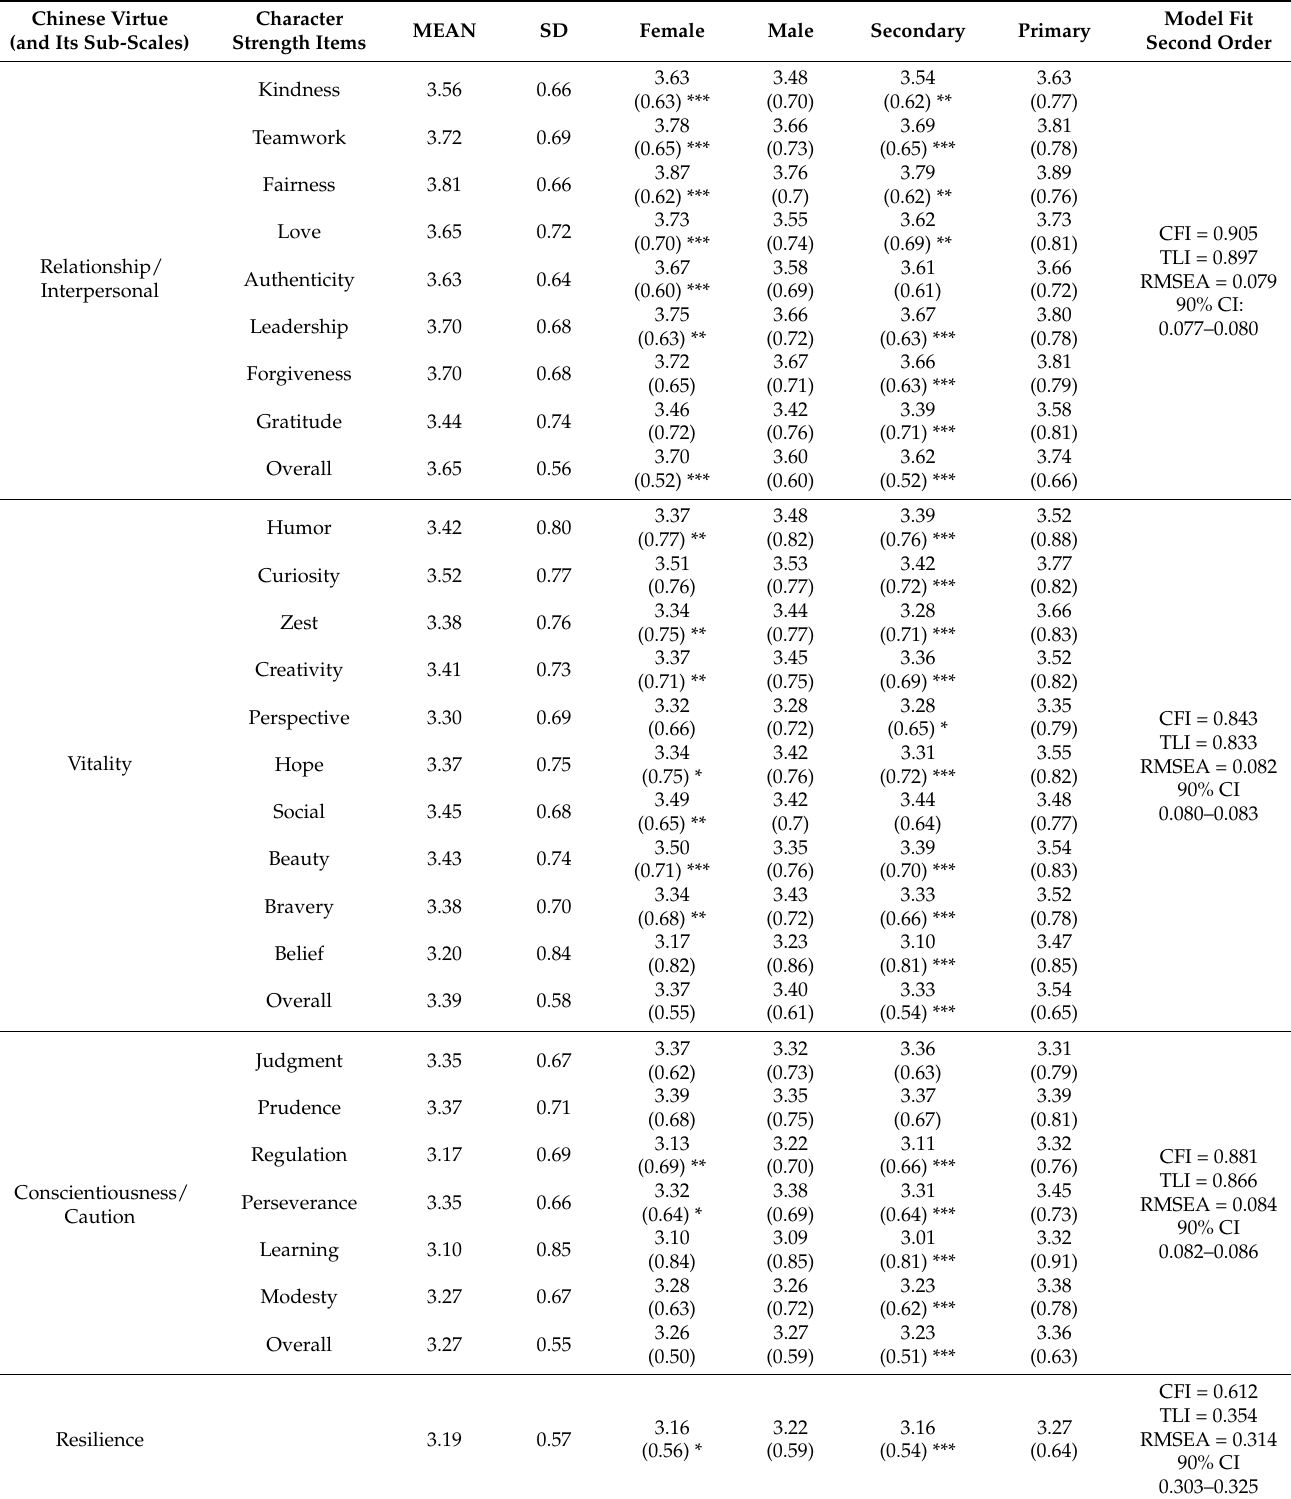
Table 1. Descriptive Statistics for the Chinese Virtues Questionnaire and Brief Resilience